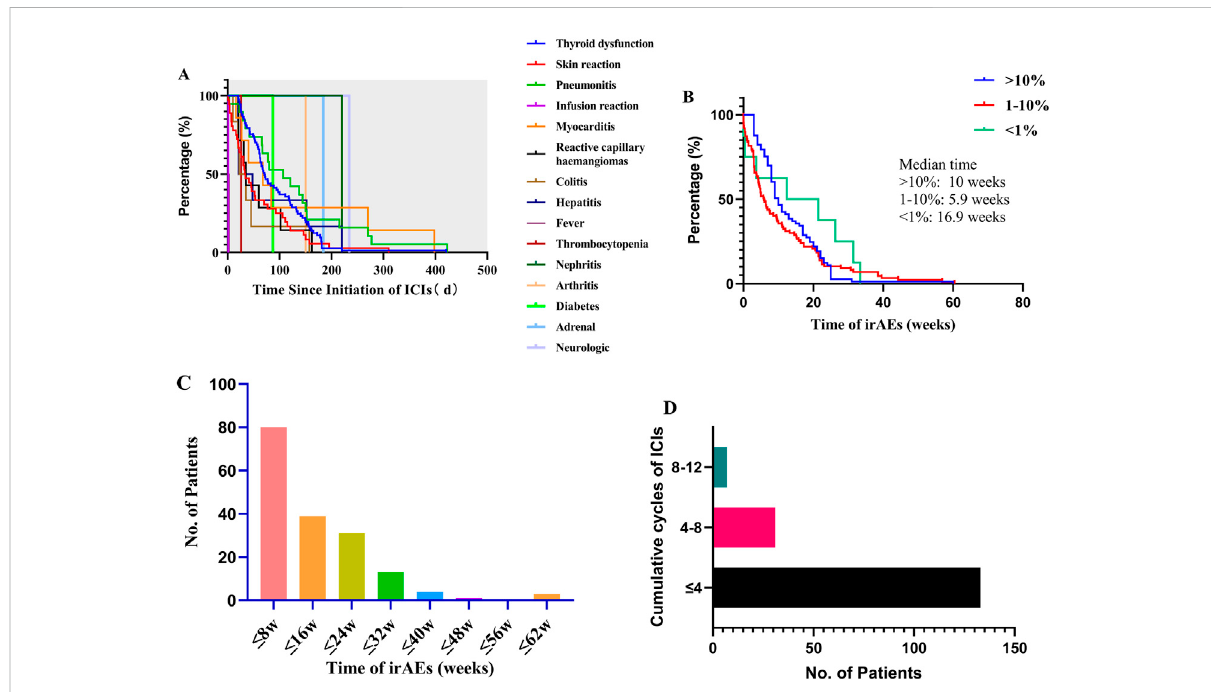
FIGURE 3 OnsettimebetweendifferentirAEsandfrequencyofallirAEsbetweenonsettimeandtreatmentcycle: (A) onsettimeofanyirAEs; (B) onsettime between different frequency of irAEs; (C) frequency of all irAEs by onset time; (D) frequency of all irAEs by treatment cycle.